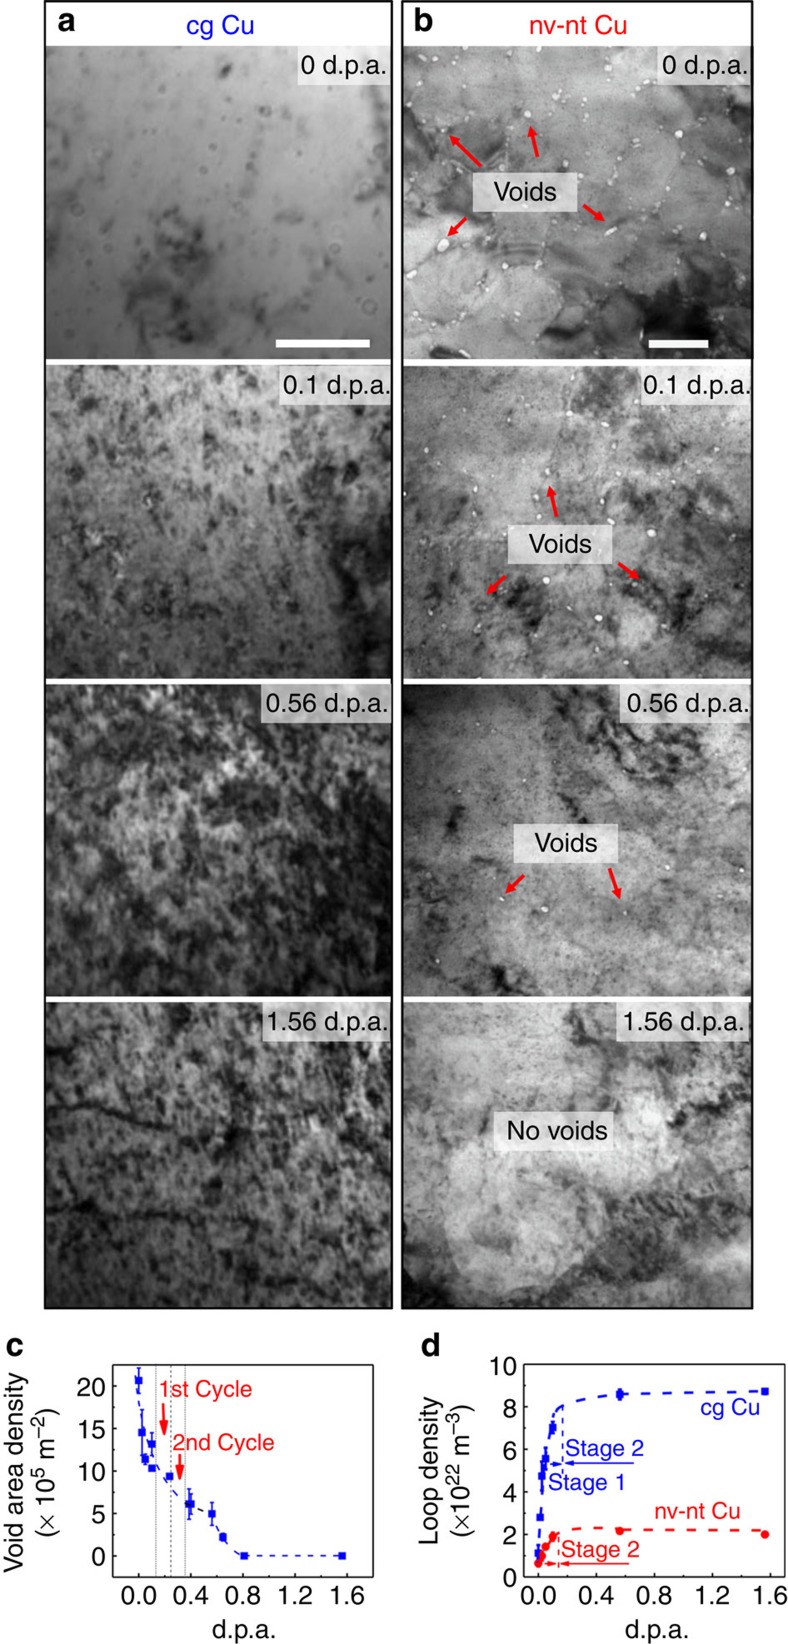
Superior radiation tolerance and void shrinkage in nv-nt Cu as evidenced by in situ Kr ion irradiation studies.TEM snapshots in (a) and (b) compare drastically different evolution of microstructure during in situ Kr ion irradiation of coarse grained (cg) and nv-nt Cu. (a) During initial radiation of cg Cu by 0.1 displacements per atom (d.p.a.), there is a rapid and prominent increase in density of defect clusters, the density of dislocation loops increased monotonically with dose and high-density dislocation segments were observed by 1.56 d.p.a.. Scale bar, 100 nm. (b) In contrast, in nv-nt Cu, the density of dislocation loops increased slightly with dose accompanied by a gradual elimination of nanovoids. Scale bar, 100 nm. (c) Up to 0.56 d.p.a., a significant decrease of area density of nanovoids was observed. By 1.56 d.p.a., nanovoids were mostly removed. The error bars of void density were determined from the s.d. from the average void density measured from several locations of the irradiated specimens. (d) A statistical study shows that the defect density in cg Cu increased rapidly to a much greater saturation level than that in nv-nt Cu.